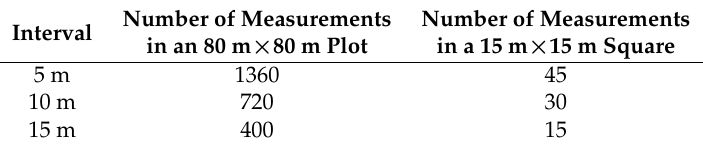
Table 4. The sampling protocols and number of